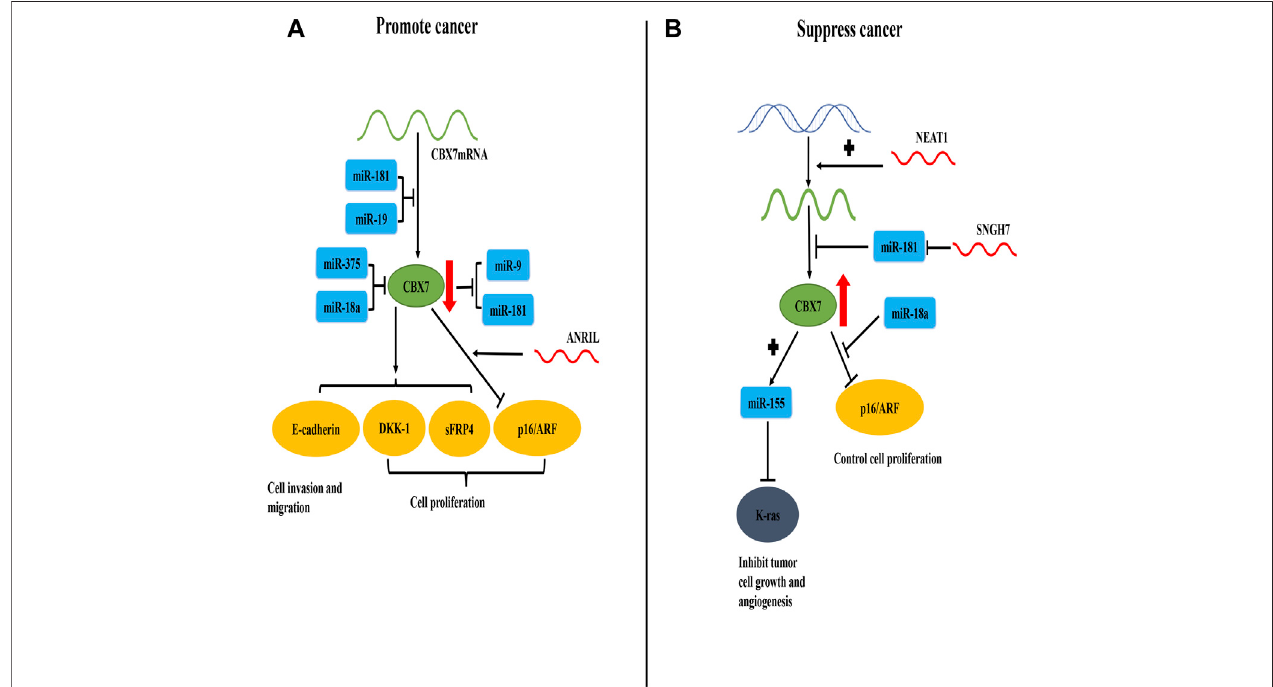
FIGURE3| CBX7expressionisregulatedbyRNAmoleculesandtheinteractionbetweenCBX7andRNAmoleculespromotesorinhibitscancerprogression. (A) In terms ofquantity, miR-181 and miR-19 combine with the 3 ′ -UTR ofCBX7 mRNA to inhibit its translation and reduce its content. In terms offunction, miR-375 and miR- 18aact onCBX7 protein todecrease its activity. Therefore,theexpression ofDKK-1,sFRP4and E-cadherinmediatedbyCBX7decreases,resultinginuncontrolledcell proliferation, cell migration and invasion. CBX7 can also strengthen the inhibition of INK4a/ARF expression under the action of ANRIL, leading to uncontrolled cell cycle regulation and cell proliferation. Meanwhile, CBX7 can also inhibit miR-9 and miR-181. (B) In terms of quantity, NEAT1 promotes the synthesis of CBX7 at the transcription level, and SNGH7 indirectly facilitates the synthesis of CBX7 protein by blocking miR-181 at the translation level. Therefore, high content of CBX7 protein can inhibit abnormal K-ras protein via miR-155, thereby controlling tumor cell growth and angiogenesis. Meanwhile, miR-18a can relieve the transcriptional inhibition of INK4a/ARF by CBX7, thereby restoring normal cell proliferation.